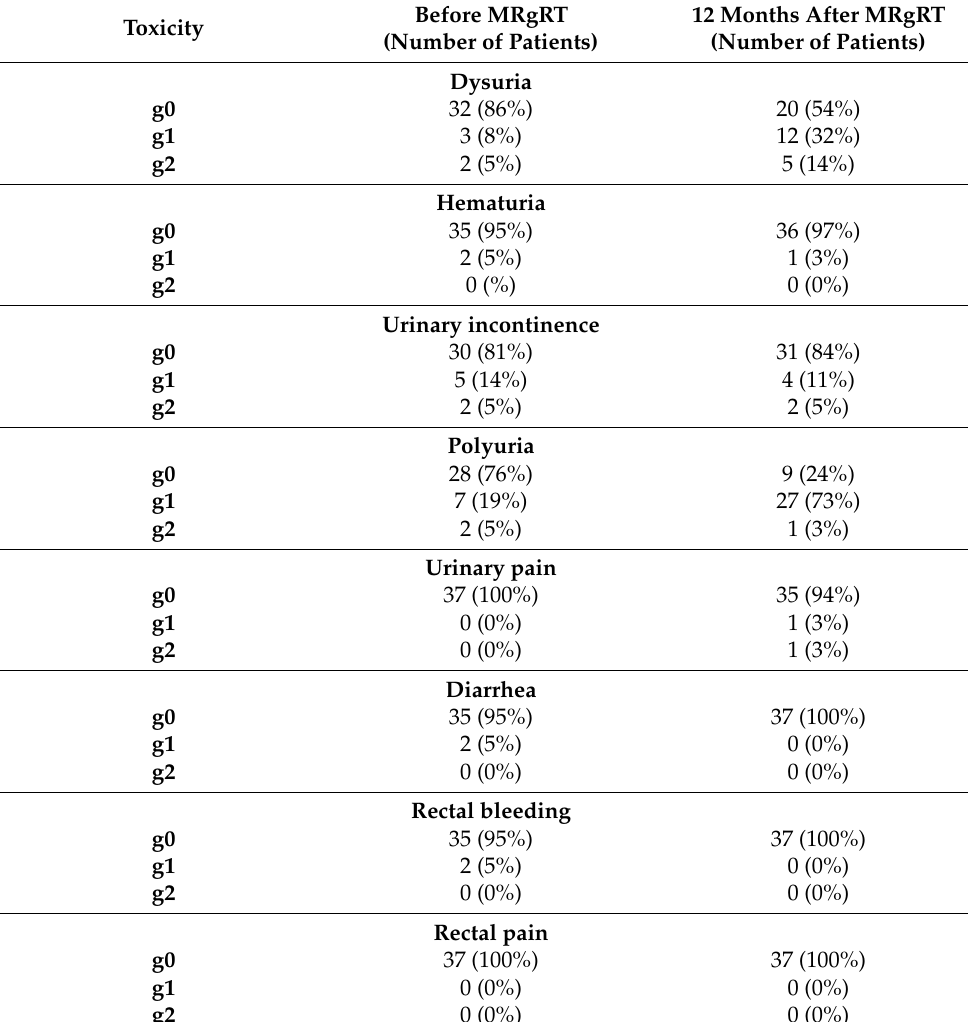
Table 5. Late GU and GI toxicities according to CTCAE